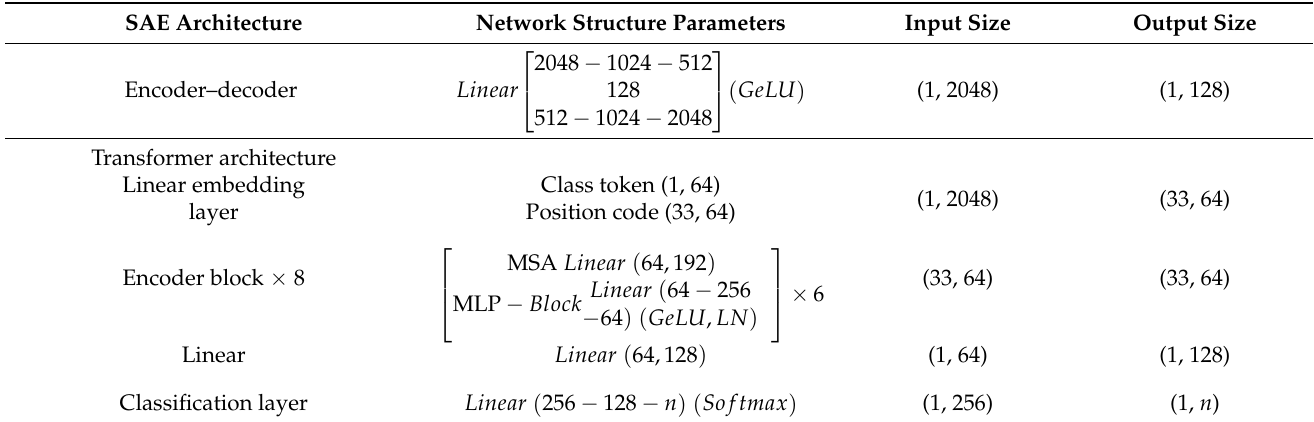
Figure 4. Flowchart of proposed VSF-ST model for time-varying speed bearing fault diagnosis. Table 2. Network structure parameters of the proposed VSF-ST